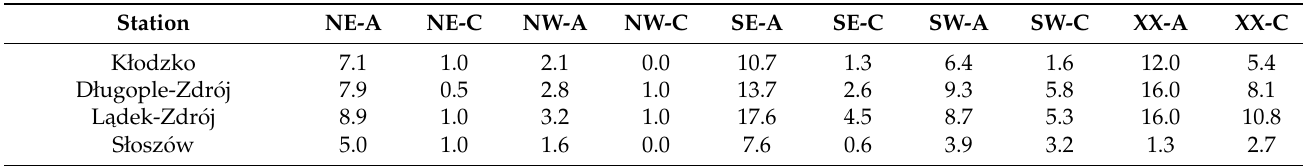
Table 8. Percentage of heat days and days with UTCI > 32 ◦ C among the total number of days with particular types of circulation for 1971–2010, based on 12:00 UTC data. Station NE-A NE-C NW-A